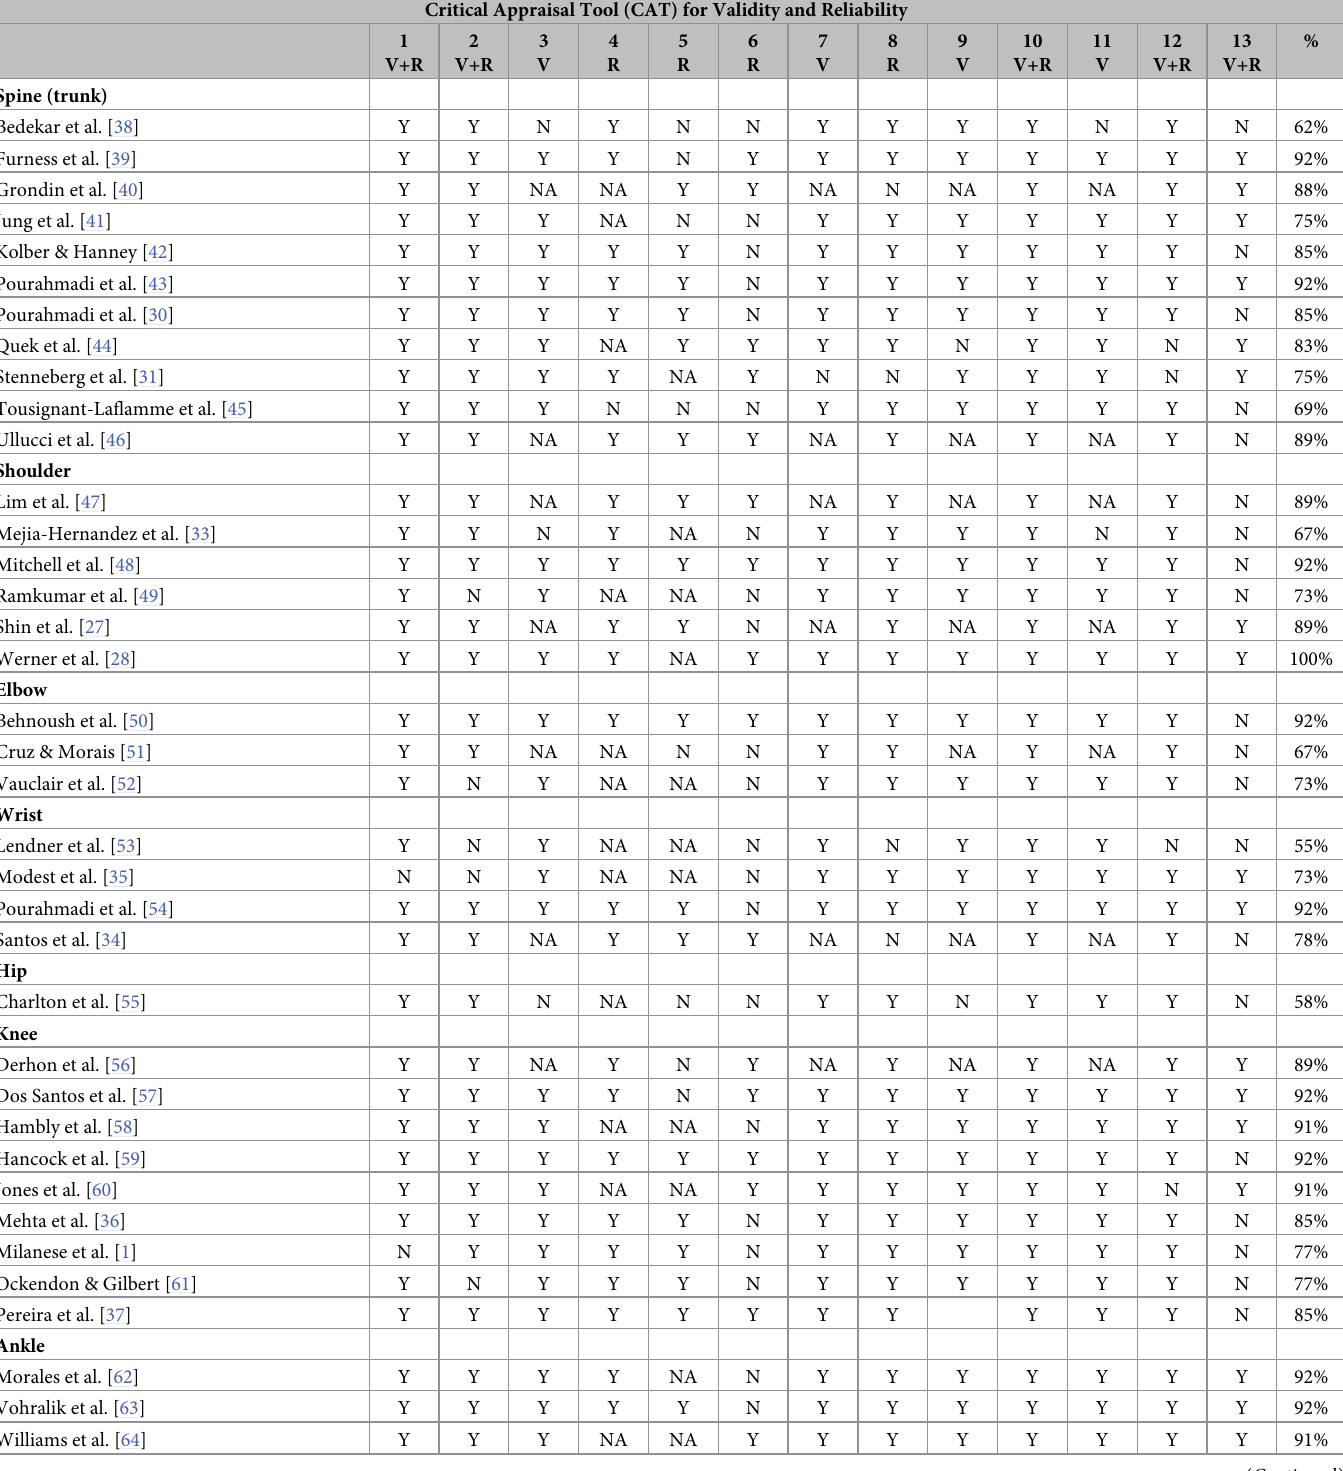
Table 2. Critical appraisal of the eligible studies. Critical Appraisal Tool (CAT) for Validity and